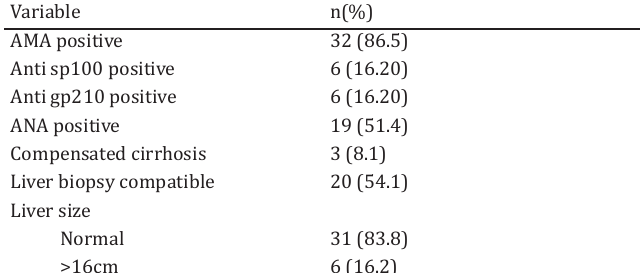
Evaluation of clinical and autoimmune markers of patients